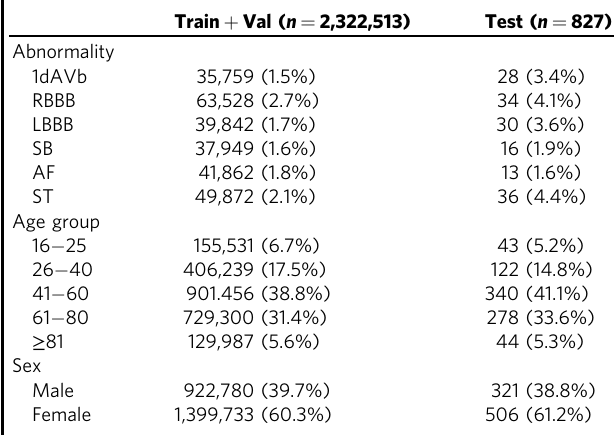
Table 1 (Dataset summary) Patient characteristics and abnormalities prevalence, n